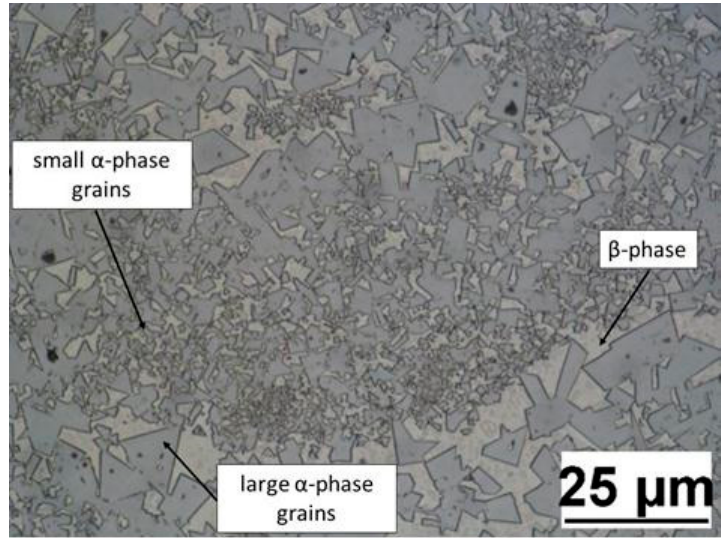
Figure 4. Micrograph of a sample cross section at 1000 × magnification with the identification of α and β phases.